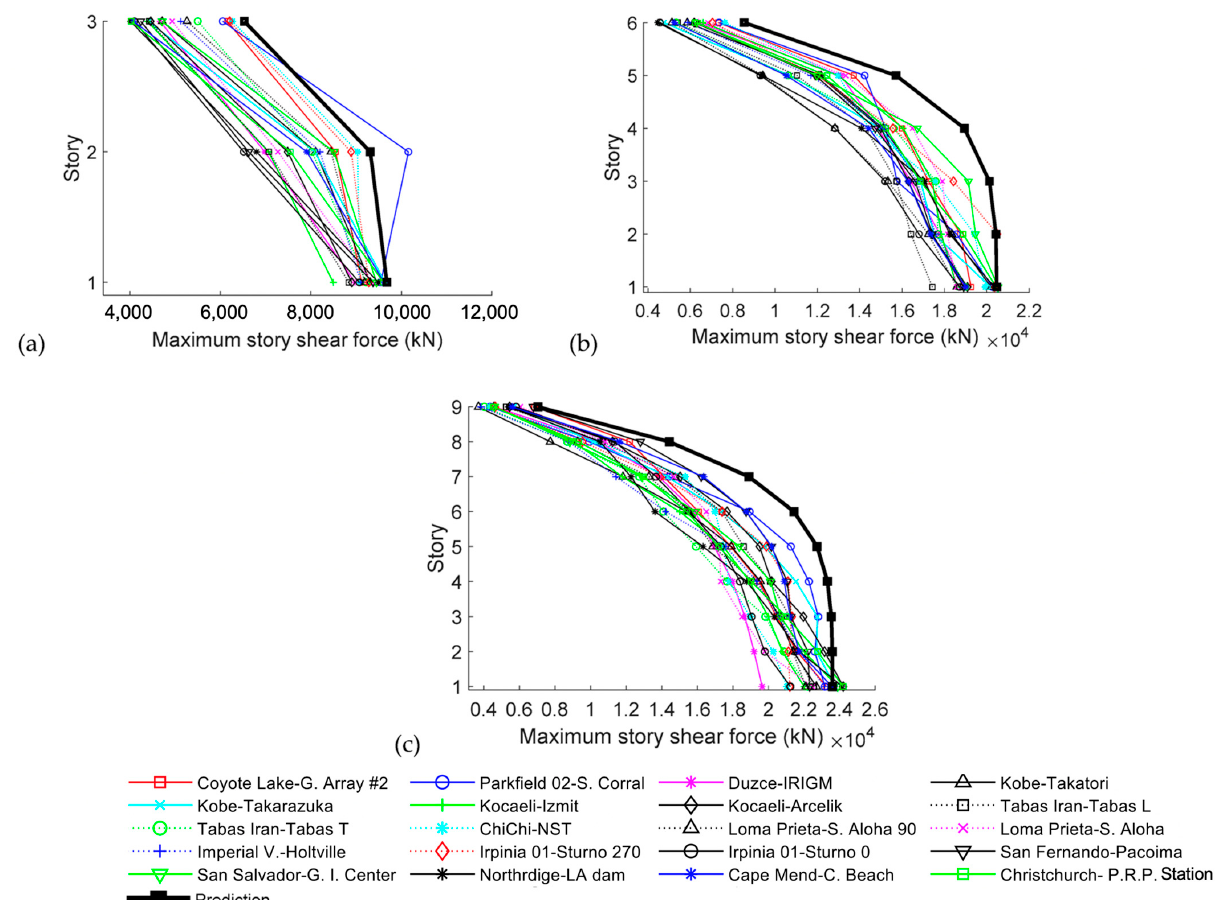
Figure 9. Maximum shear forces for prototypes N3 ( a ), N6 ( b ) and N9 ( c